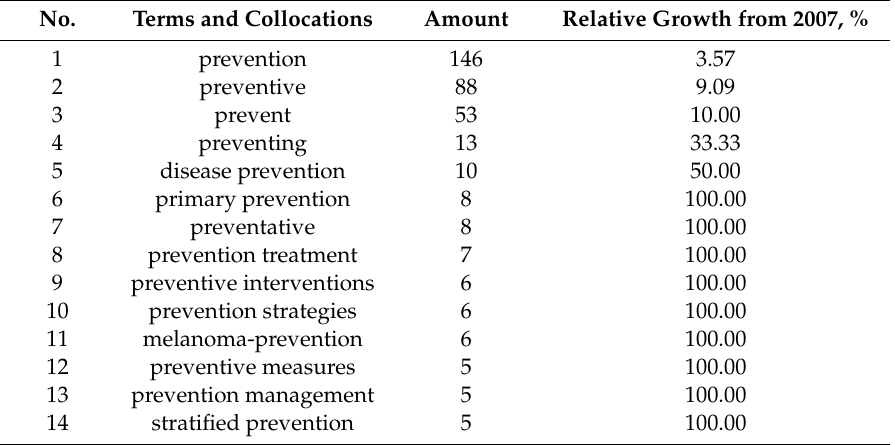
Table 6. Terms and collocations with the root word “prevent” (yellow color in cyberspace).